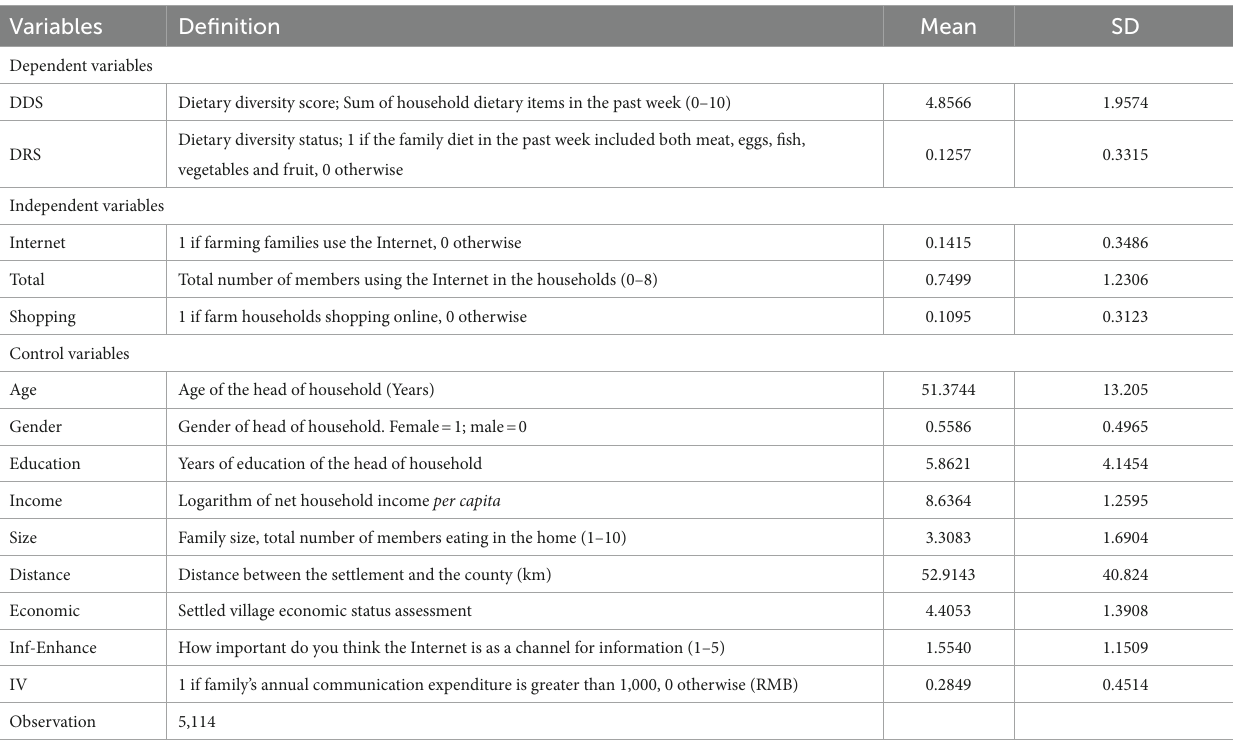
TABLE 1 Definition and descriptive statistics of the variables